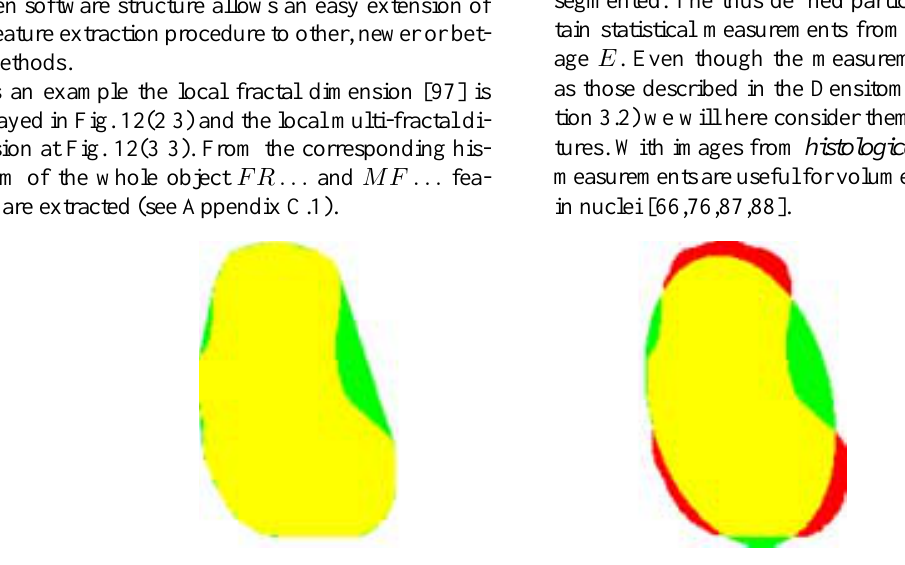
Fig. 10. Illustration of the convex hull, deficiency, best fit ellipses and elliptic deviation. The original mask is bright gray or bright gray/black resp., deficiency (left) is dark gray and elliptic deviation (right) is dark gray and black. This figure can be viewed on http://www.esacp.org/ acp/2003/25-1/rodenacker.htm.